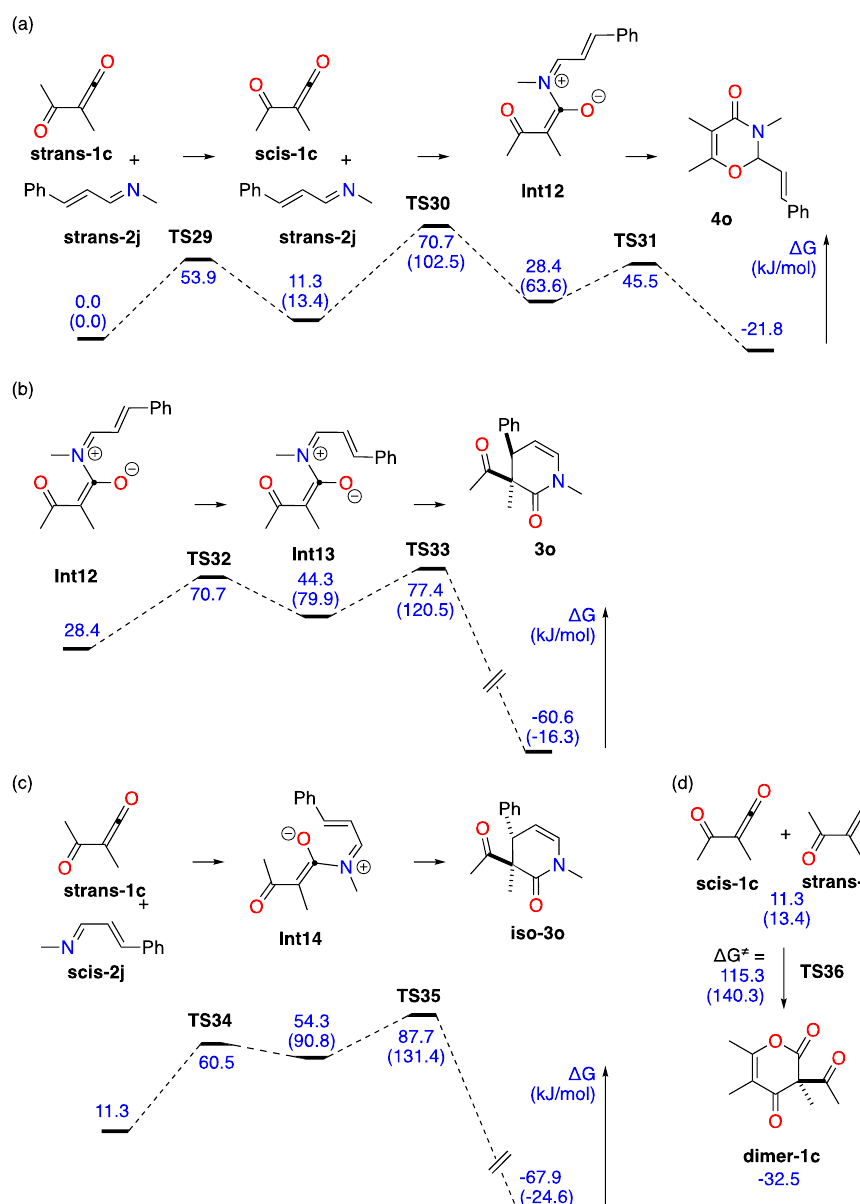
Figure 6. Free Gibbs energy profiles computed at 298 K (DFT, B3LYP-D3 / 6-311 ++ G(d,p)) of the aza-Diels − Alder reactions between the α -oxoketene 1c and the 1-azadiene 2j . Free Gibbs energies noted between parentheses were computed at 473 K.